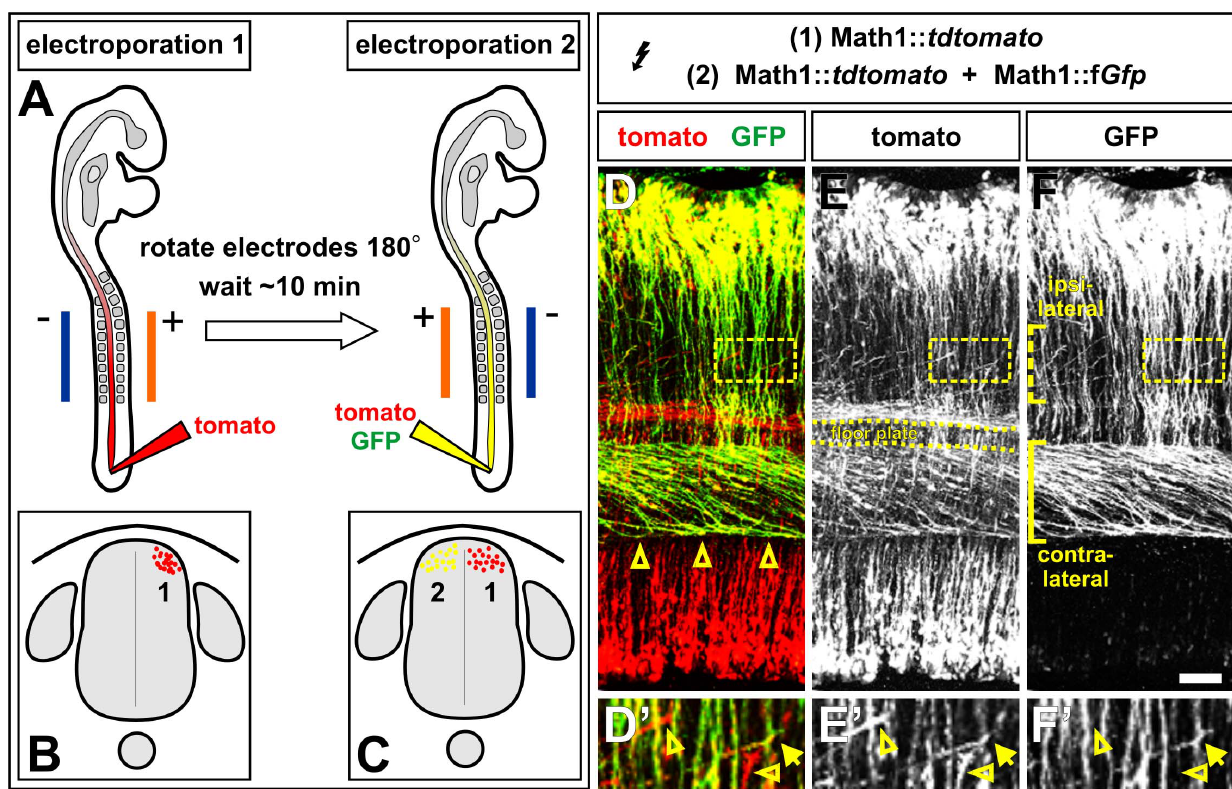
Figure 1. Double in ovo electroporation permits the independent manipulation of bilateral commissural axon trajectories. (A–C) Schematic diagram illustrating the double in ovo electroporation procedure. In the first electroporation, a single fluorophore, here tandem dimer (td) tomato [51], is introduced into HH stages 14/15 chicken spinal cords using a double dose of electrical pulses (B). The electrodes are then rotated 180 u . After a brief pause, two fluorophores, tdtomato and farnesylated (f) GFP, are introduced into the spinal cord using a single dose of pulses in a second electroporation. If the fluorophores are delivered under the control of the Math1 enhancer [37], this strategy will result in the bilateral symmetric populations of commissural neurons being differentially labeled either red or yellow (C). (D–E) Longitudinal ‘‘open book’’ preparations from HH stage 23/24 double in ovo electroporated chicken spinal cords. The trajectory of the tomato + GFP + (yellow) commissural axons can be easily distinguished against the ubiquitous background of tomato + (red) commissural axons. There are two classes of yellow (and red) ventrally projecting commissural axons: an ipsilateral population that turns before the floor plate (FP, dotted bracket, F) and a contralateral population that makes a sharp rostral turn after crossing the FP (open arrowheads, D; solid bracket, F). (D’–F’) Higher magnification images of the boxed region in D–F show that the yellow ipsilateral population of commissural axons (arrow) can easily be distinguished from the red contralateral population (open arrowheads’). Scale bar: 60 m m.